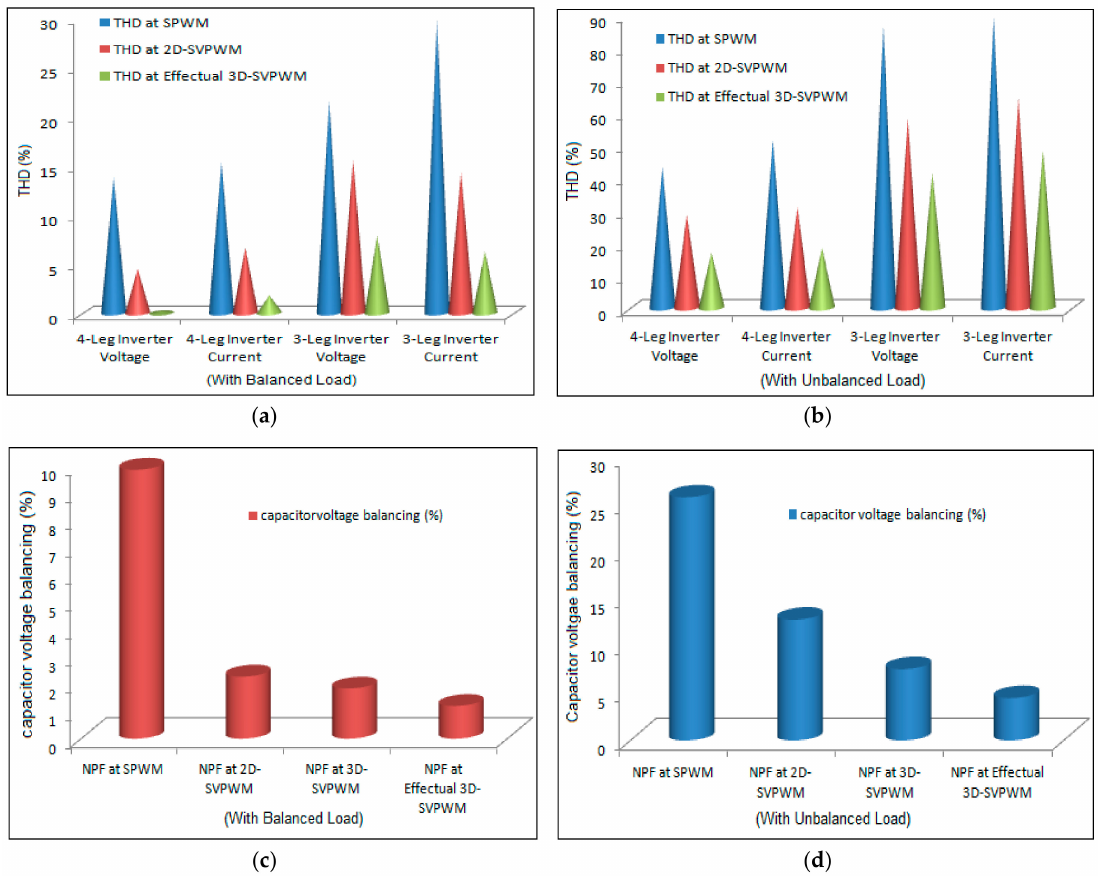
Figure 16. Simulation results comparison for various scheme ( a ) THD analysis with balanced load; ( b ) THD analysis with unbalanced load; ( c ) capacitor voltage balancing for balanced load; and ( d ) capacitor voltage balancing for unbalanced